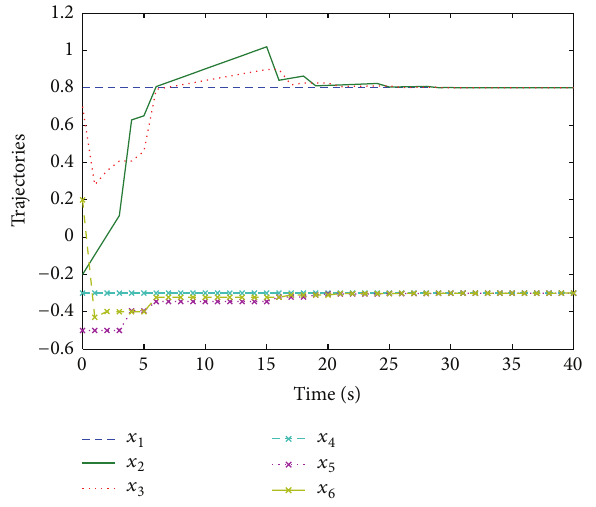
Figure 3: State trajectories for discrete-time case.